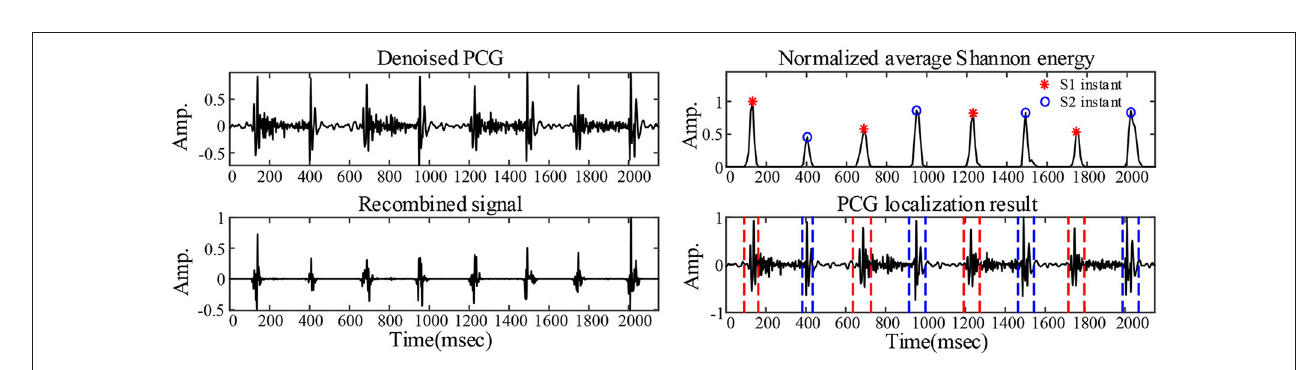
FIGURE 7 | PCG segmentation after noise